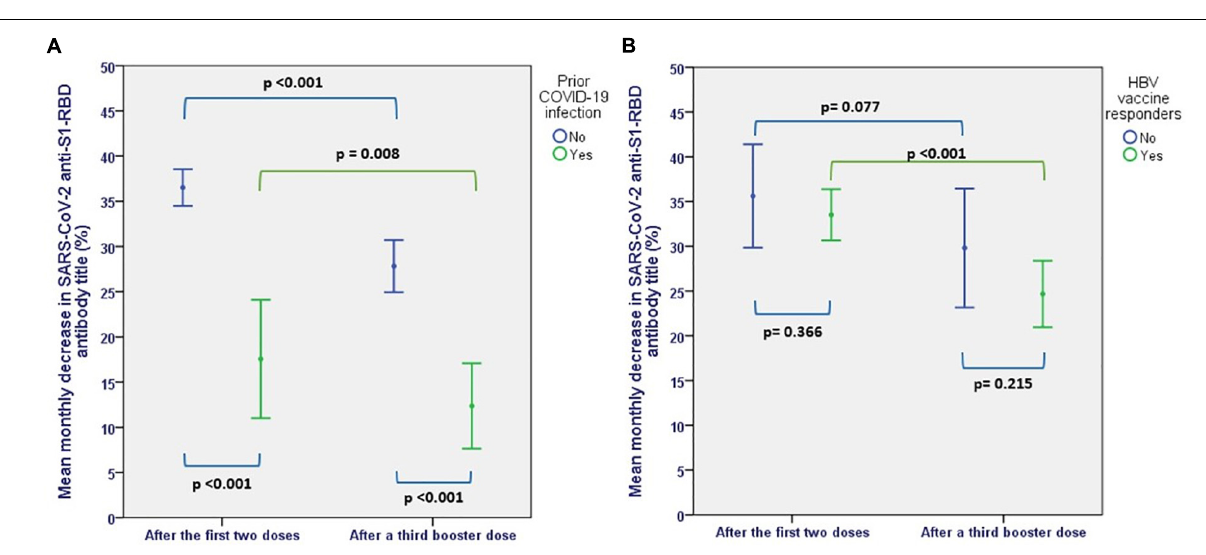
FIGURE 6 | Mean monthly decrease in SARS-CoV-2 AntiS(RBD) antibodies before and after a third booster dose, (A) according to prior SARS-CoV-2 exposure, (B) according to response to HBV